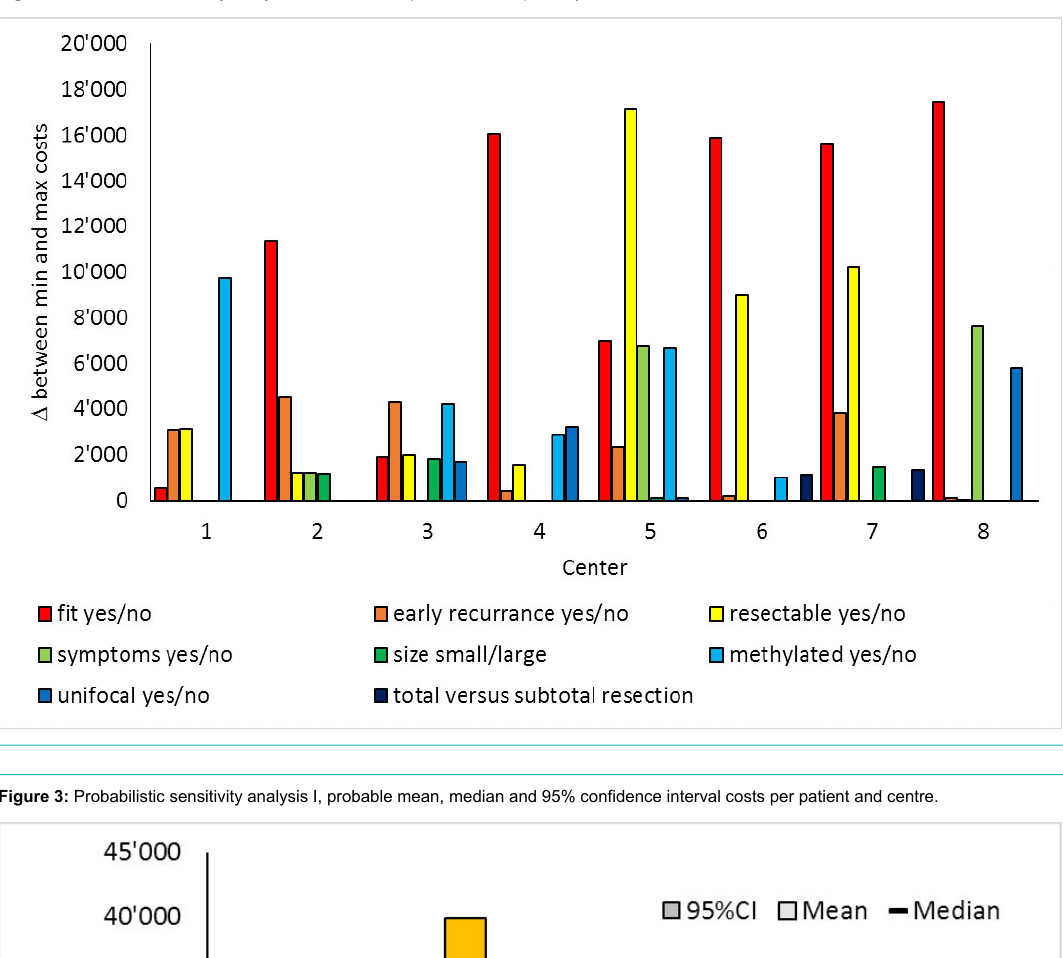
Figure 2: Univariate sensitivity analysis for all decision probabilities separately.